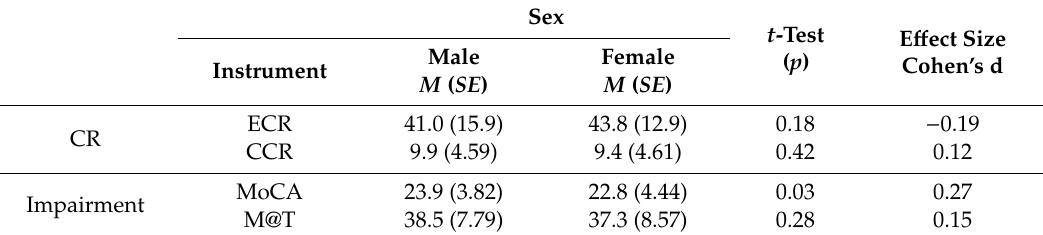
Table 3. Sample descriptives using t-test.